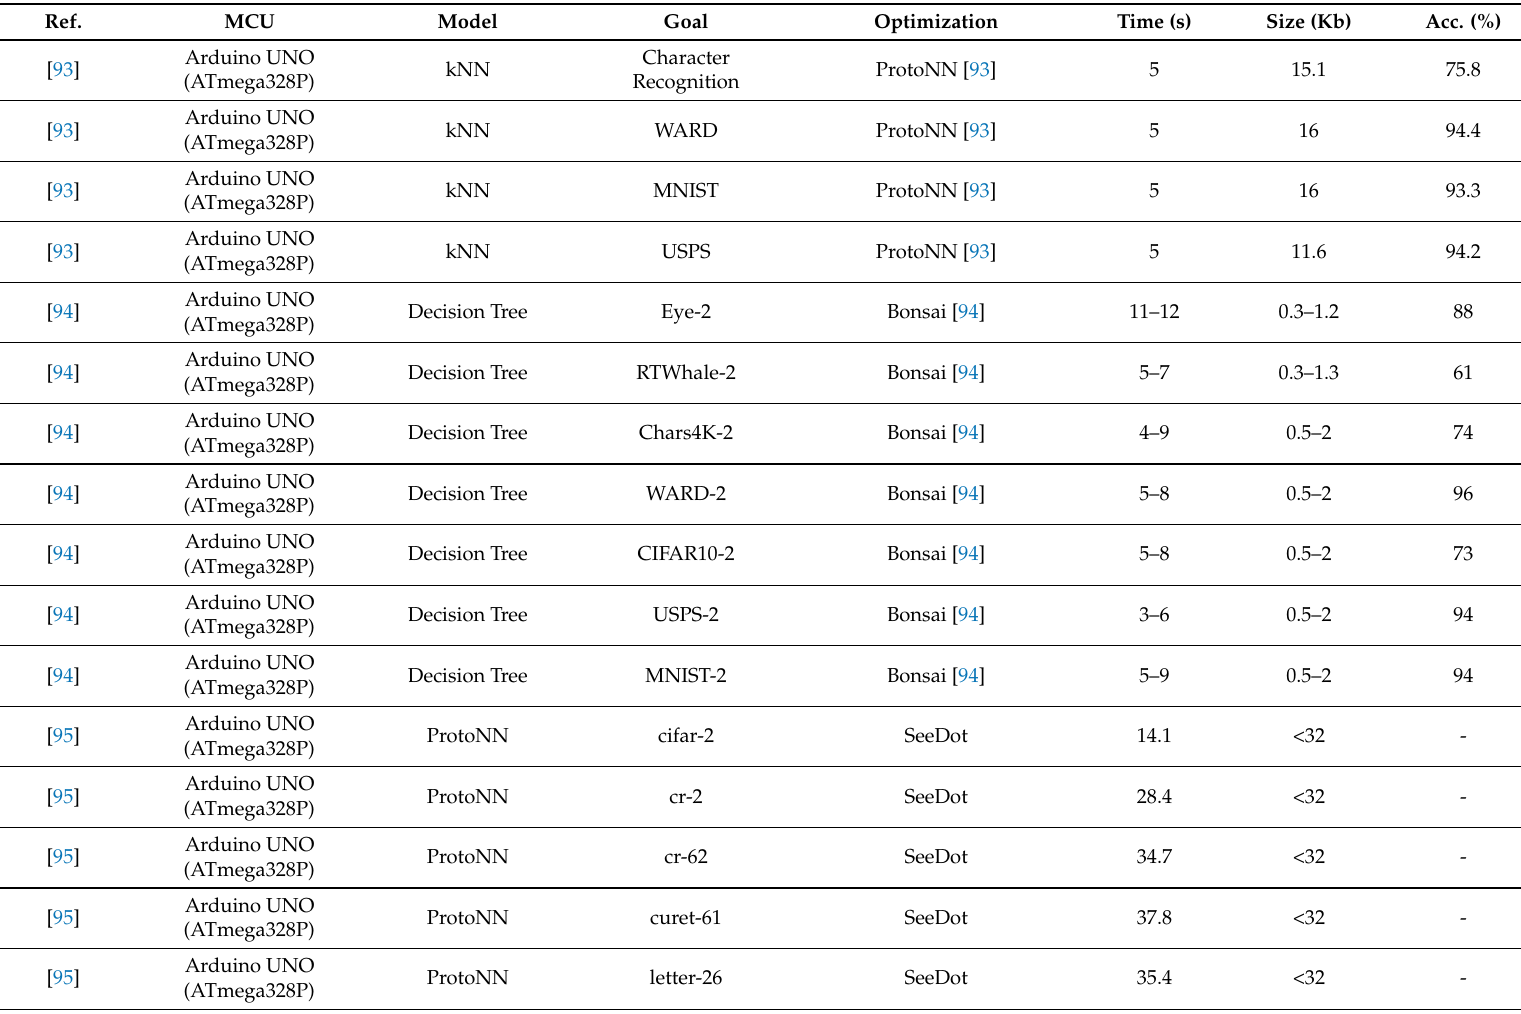
Table A1. The table summarizes the novel algorithms and ML models implemented in the resource-scarce MCUs. The table contains information about the hardware, models, and optimizations made. If available, the table shows the execution, memory, and performance obtained by the algorithm.